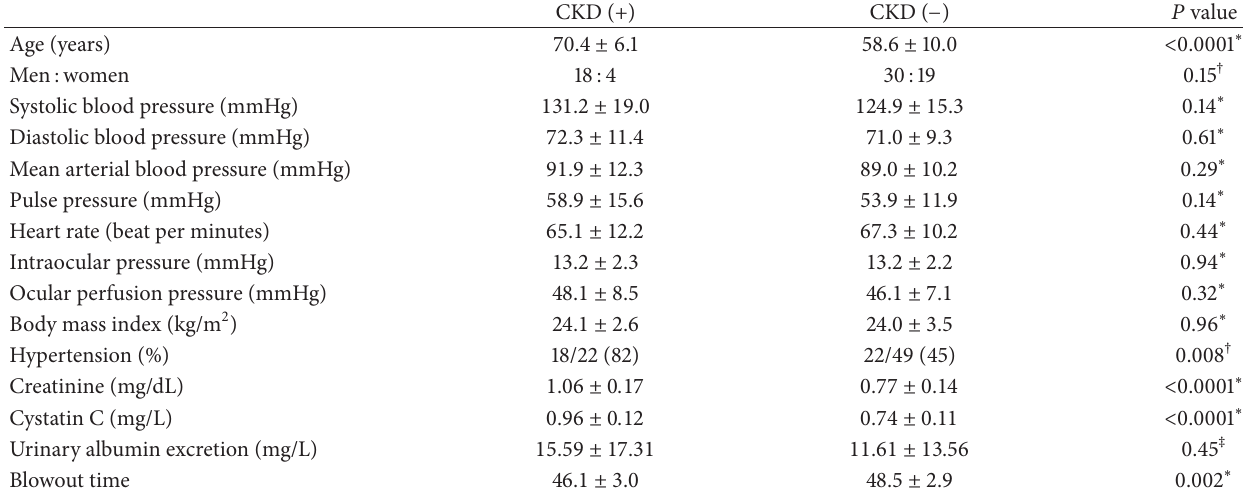
Table 5: Results of all parameters in patients with the chronic kidney disease (CKD) and without CKD.